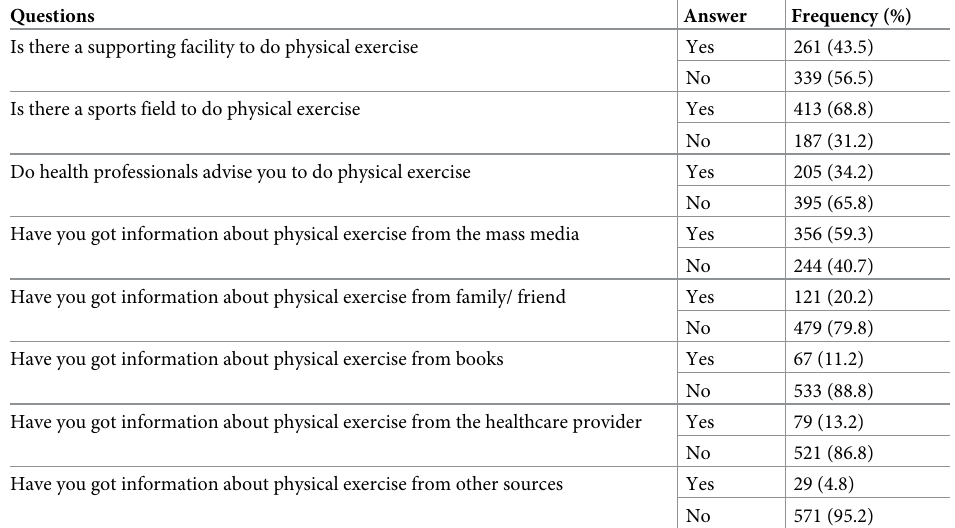
Table 8. Health service characteristics and source of information about antenatal physical exercise during preg- nancy among pregnant women in Hawassa city, Sidama Regional State, Ethiopia, 2021.